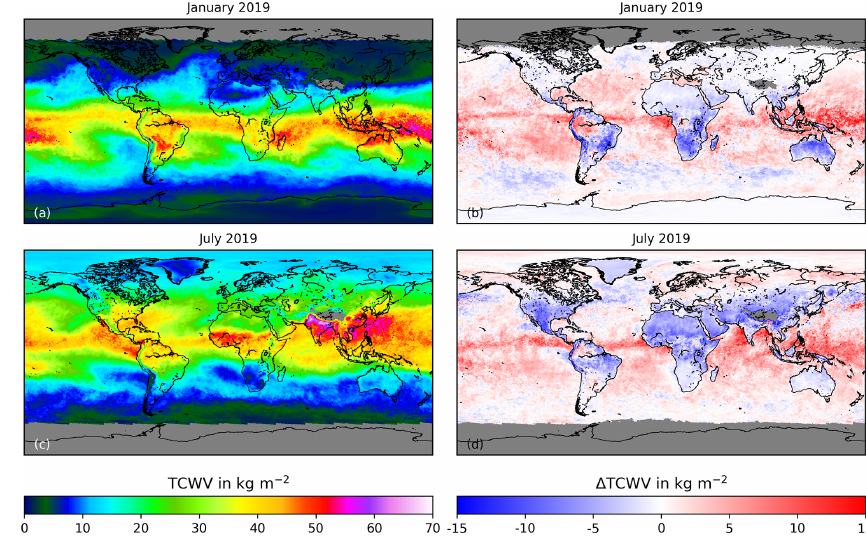
Figure 9. As Fig. 8 but for the AMC-DOAS GOME-2B TCWV